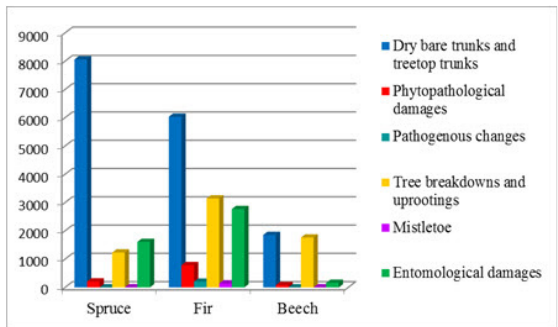
Figure 2. Types of forest trees